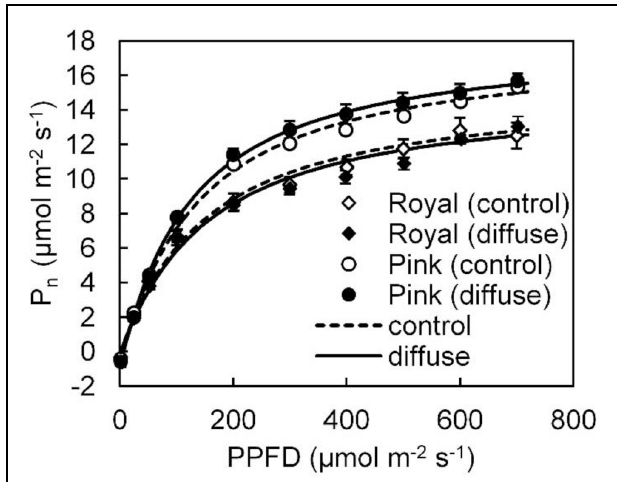
FIGURE 2 | Steady state net leaf photosynthetic ( P n ) light response curves in ‘Pink Champion’ and ‘Royal Champion’ in the control and diffuse light treatments. The measurements were taken in March 2013 (winter growing season). During the measurements, air temperature, CO 2 concentration, VPD in the measurement chamber were maintained at 25 ◦ C, 800 µ mol mol − 1 , and between 0.5–1 kPa, respectively. Lines represent the fit of the non-rectangular hyperbola function (Eq. 2). Error bars show ± SE ( n =